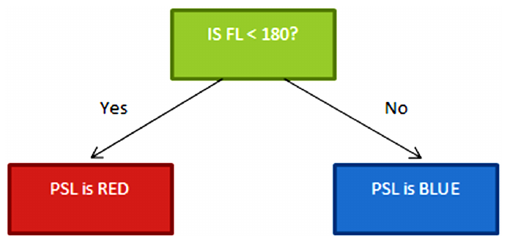
Figure 1. An example of a small decision